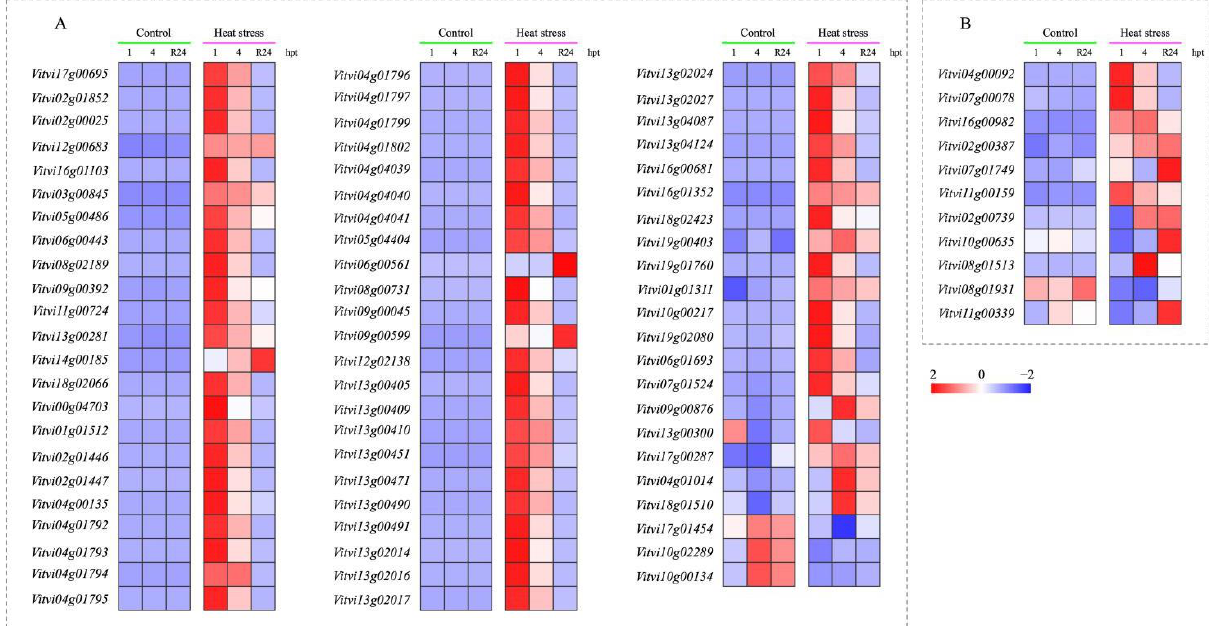
Figure 7. Transcriptomic profiles of DEGs contained in the HSP ( A ) and HSF ( B ) families following HS treatment and subsequent recovery. Different shades of red and blue express the average FPKM value (log2 transformed) of the gene in each sample, as illustrated in the legend.